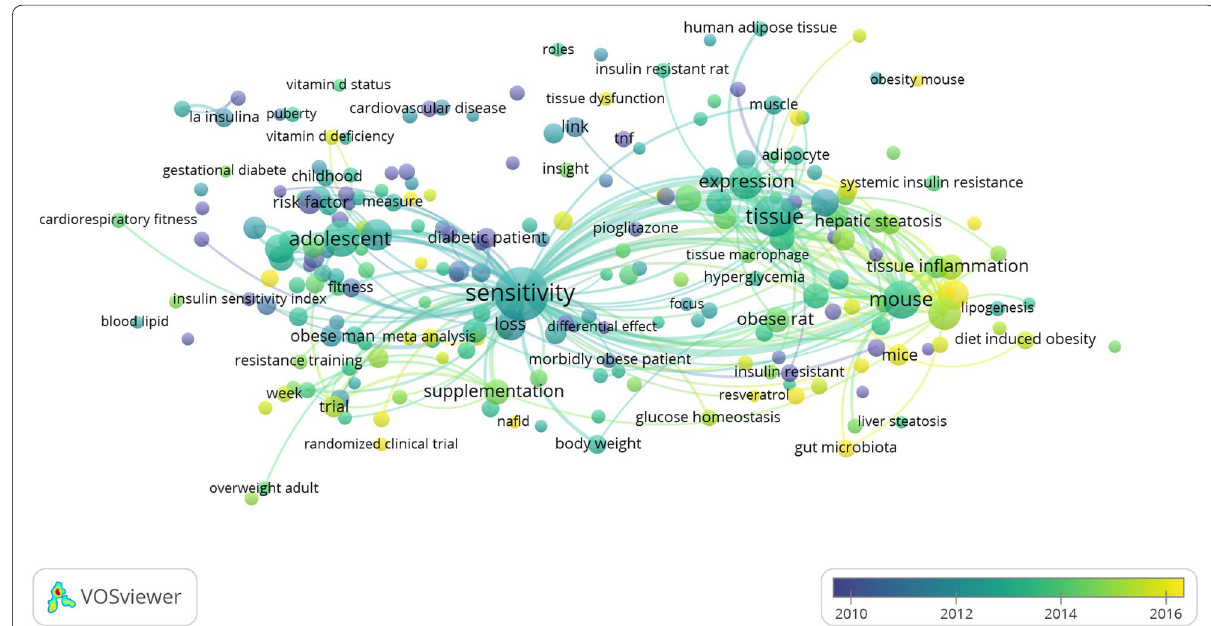
Fig. 6 Network visualization map of the analysis of terms in the titles according to the frequency of appearance. The color blue denotes earlier occurrences of the terms, and the color yellow denotes the later occurrence. The map was created using VOSviewer software version